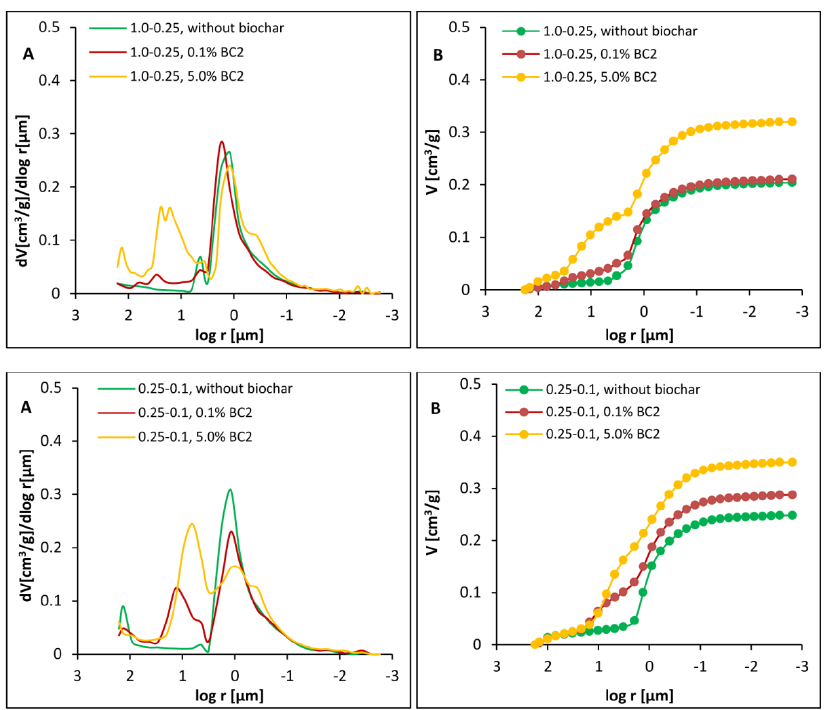
Figure 5. Differential ( A ) and cumulative ( B ) curves of pore volume vs. equivalent pore radius of cylinders remolded using selected Dystric Cambisol fractions with and without sunflower husk biochar; the curves were drawn based on the average value of three measurements. Agronomy 2020 , 10 , x FOR PEER REVIEW